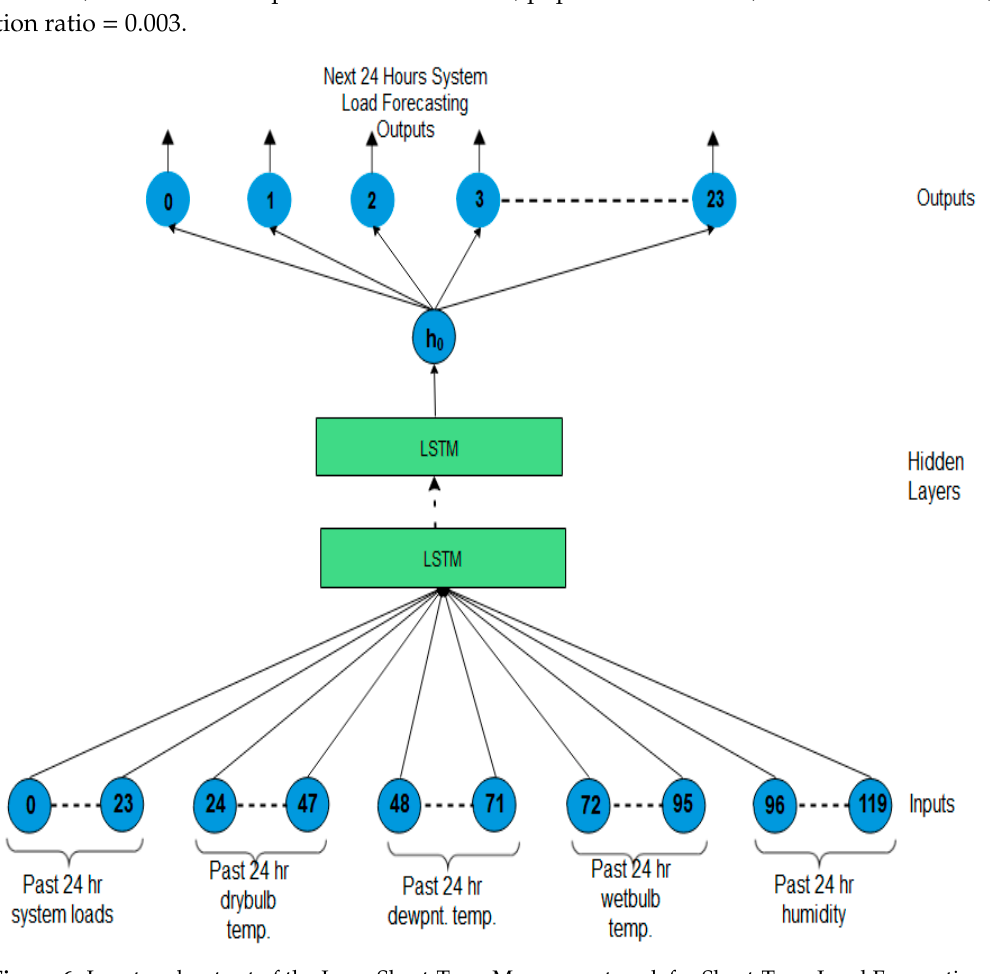
Figure 6. Input and output of the Long Short-Term Memory network for Short-Term Load Forecasting.